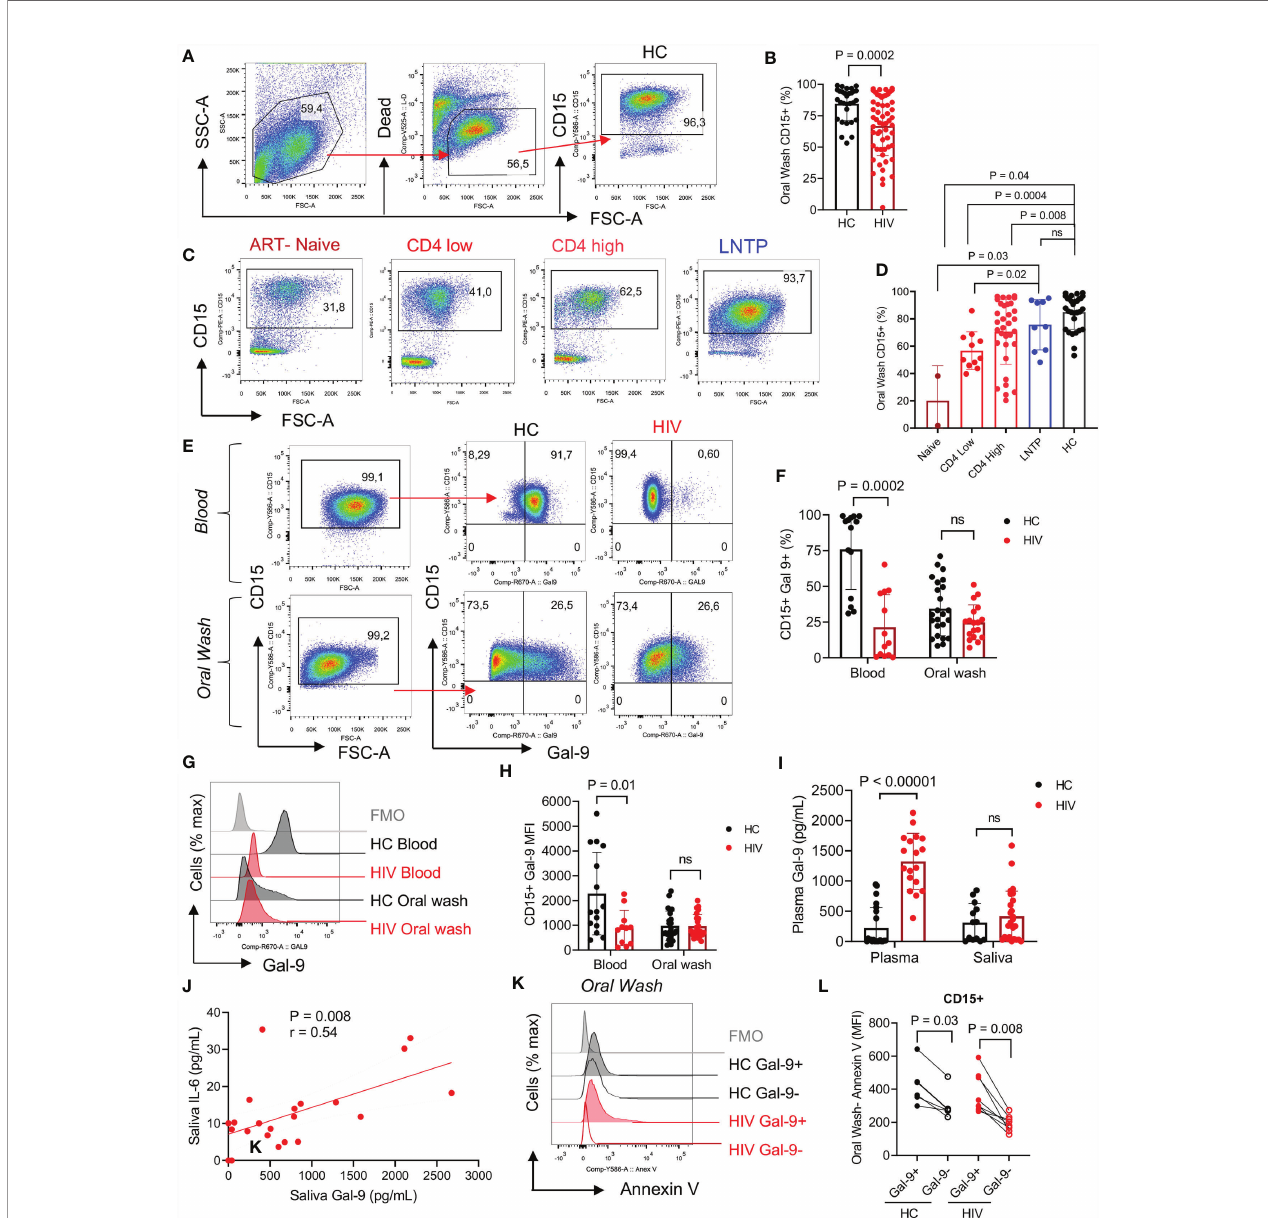
FIGURE 2 | Neutrophils in the oral cavity are decreased in HIV-infected individuals and have low surface Gal-9. (A) Representative fl ow cytometry plots for CD15 + neutrophil identi fi cation in the oral wash. (B) Cumulative data of percentages of CD15 + cells in the oral washes of HCs compared to HIV-infected individuals. (C) Representative fl ow cytometry plots, and (D) cumulative data of neutrophils in oral washes of different HIV-infected individuals (ART-naïve, on ART with low CD4 + T cell count (< 200 cells/ul) or high CD4 + T cell count (> 200 cells/ul), and long-term non-progressor (LTNP) compared to HCs. (E) Representative fl ow cytometry plots, and (F) cumulative data of Gal-9 surface expression in neutrophils from the blood and oral washes of HIV and healthy individuals. (G) Representative histogram plots, and (H) cumulative data of Gal-9 expression measured by the Mean Fluorescence Intensity (MFI) on blood and oral neutrophils of HIV-infected and healthy individuals. (I) Cumulative data of soluble Gal-9 in the plasma and saliva of HIV-infected and healthy individuals as measured by ELISA. (J) Cumulative data of a positive correlation between the saliva Gal-9 with the saliva IL-6 (Spearman correlation, r = 0.54, P = 0.008). (K) Representative histogram plots, and (L) cumulative data of apoptosis in oral neutrophils in regard to Gal-9 expression measured by Annexin V assay. ns, no signi fi